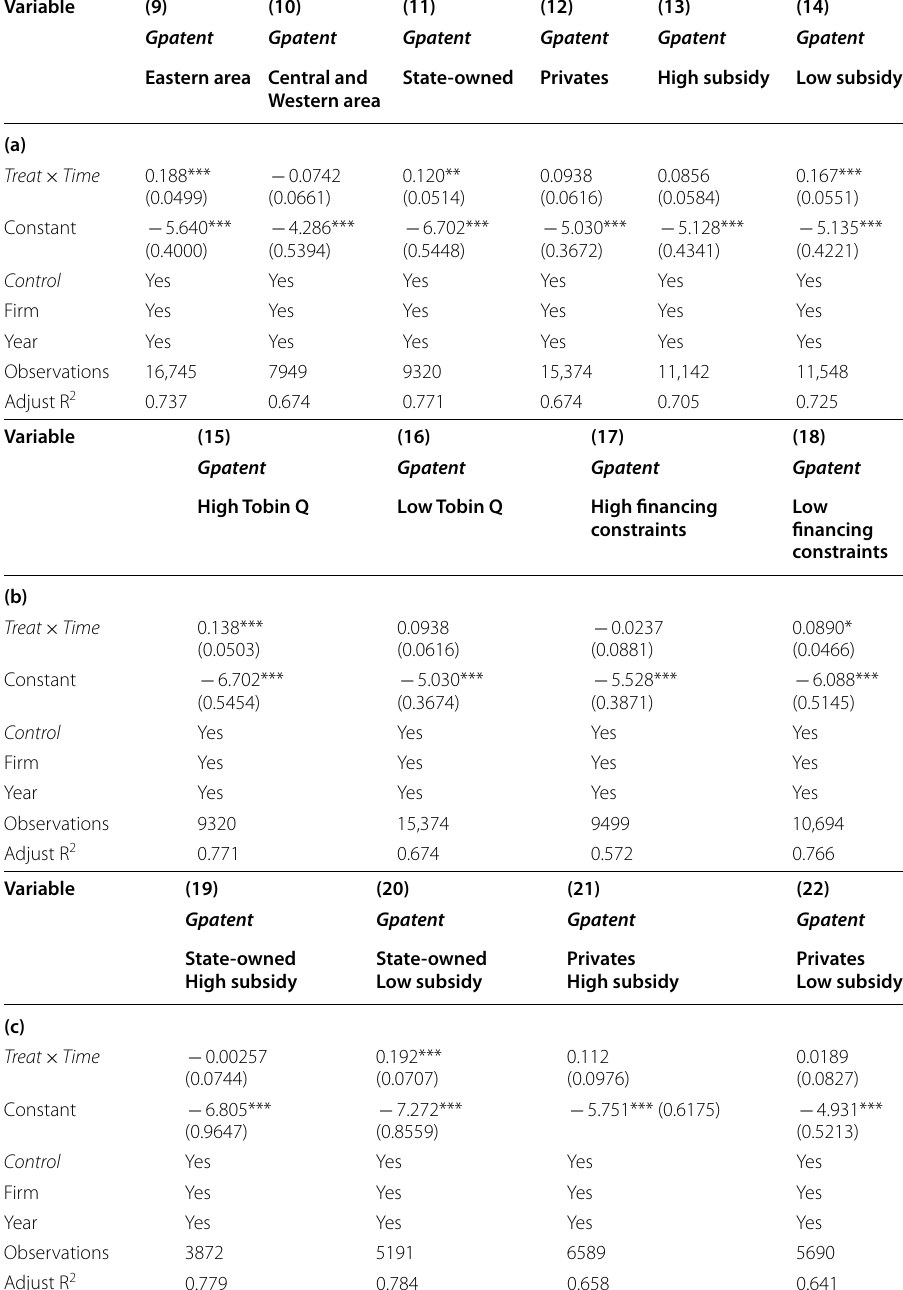
Table 6 Results of heterogeneity